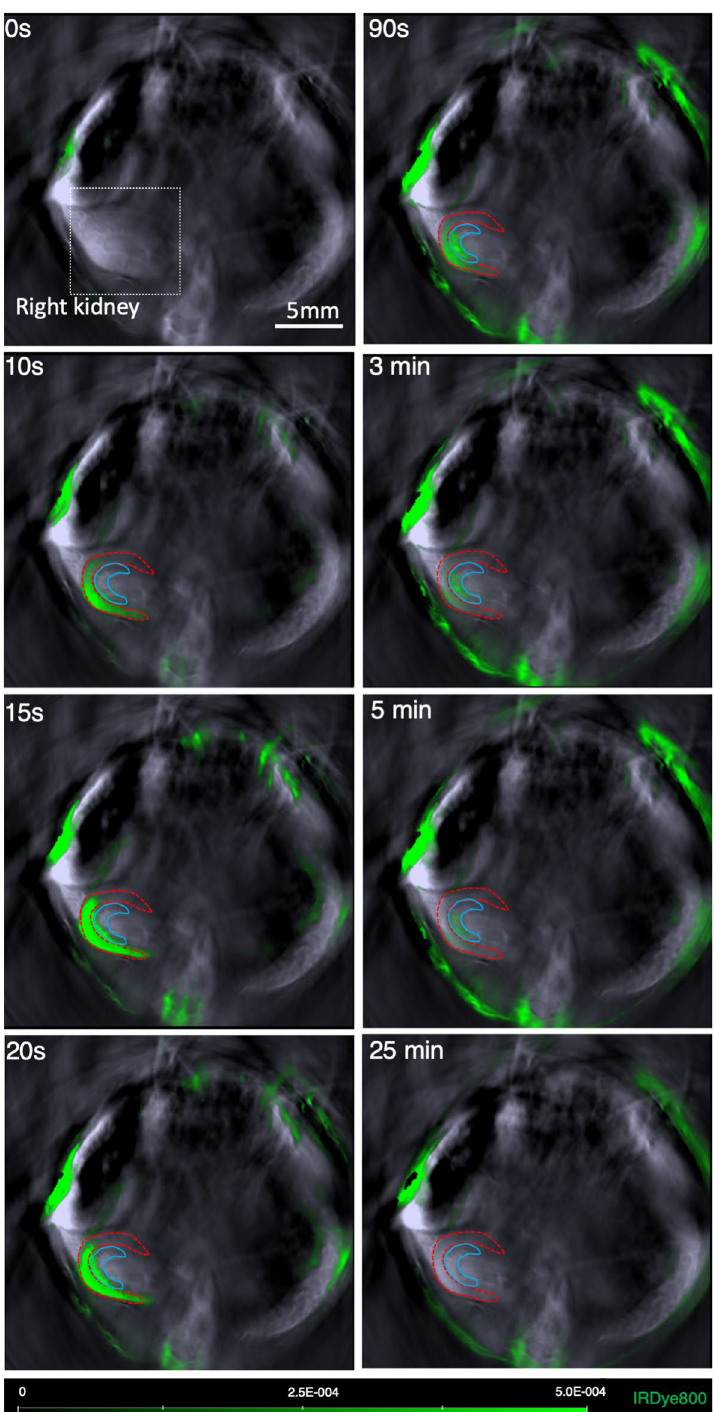
Figure 1. Representative MSOT images showing the clearance of IRDye800CW from mouse kidneys. IRDye800CW (60 nM dissolved in 0.9% saline) was injected intravenously into WT mice 24 h after sham operation. The clearance/movement of IRDye800CW (green) in the cross section of the right kidney (white square) was recorded. ROIs in cortex and medulla/pelvis region of the kidney are delineated in red and blue, respectively. Representative images of 28 mice (n = 7 in each group). The green bar represents the scale for the mean pixel intensity of the IRDye800CW